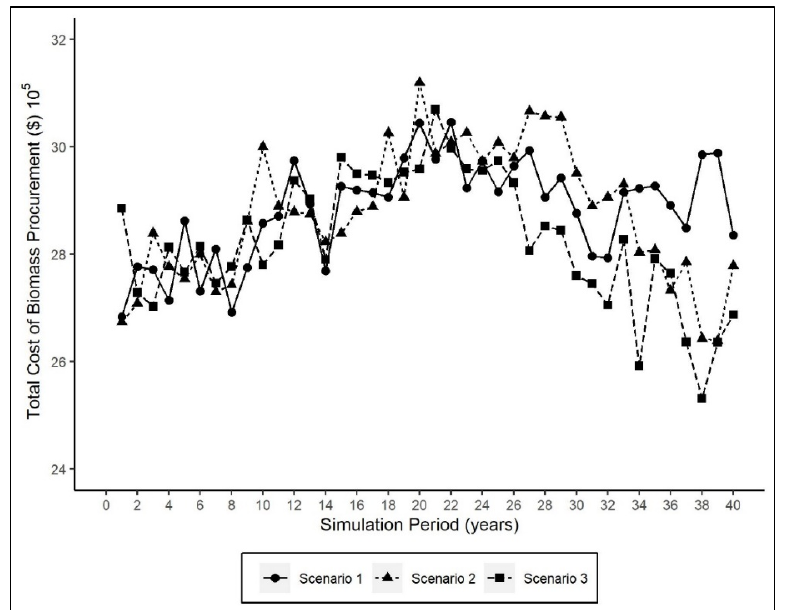
Figure 11. Distribution of total cost of pulpwood procurement at different years of the simulation period. Scenarios 1, 2 and 3 are differentiated in Table 1.